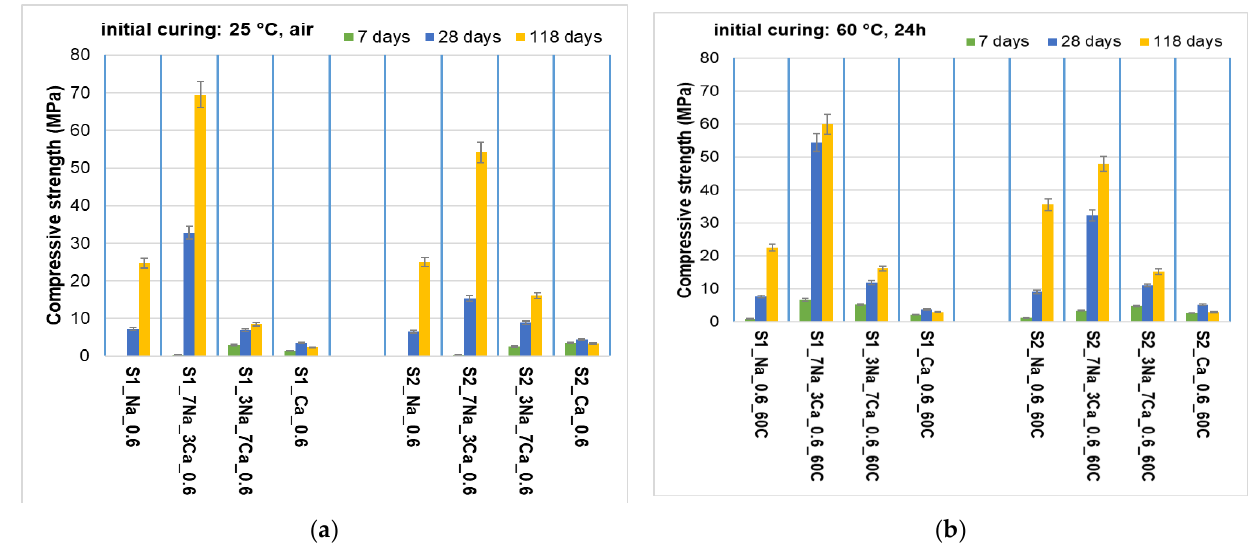
Figure 6. Compressive strengths vs. time for: ( a ) samples obtained with S1 and S2 glass powders stored at 25 °C; ( b ) samples obtained with S1 and S2 glass powder cured at 60 °C for the first 24 h and then stored at 25 °C.